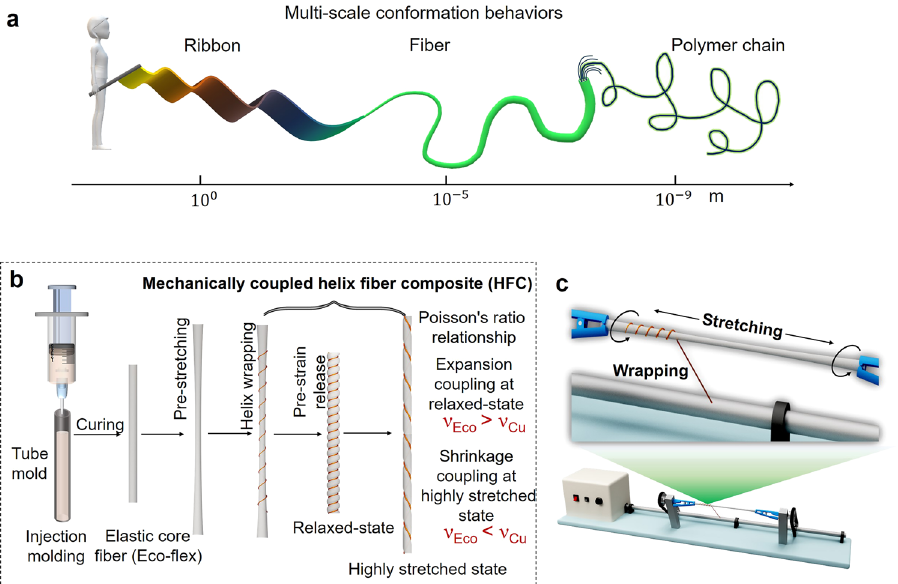
Fig. 1 Multiscale chain-conformation-like behaviors for soft matter and the design of cross-scale conformation coupled helix fi ber composite (HFC). a The multi-scale conformation behaviors as demonstrated by a ribbon belt. b Schematic illustration of the typical wire-on-elastomer wrapping strategy for the preparation of helix fi ber composites (HFC). ν is Poisson ’ s ratio. c Schematic of the experimental setup for preparing the